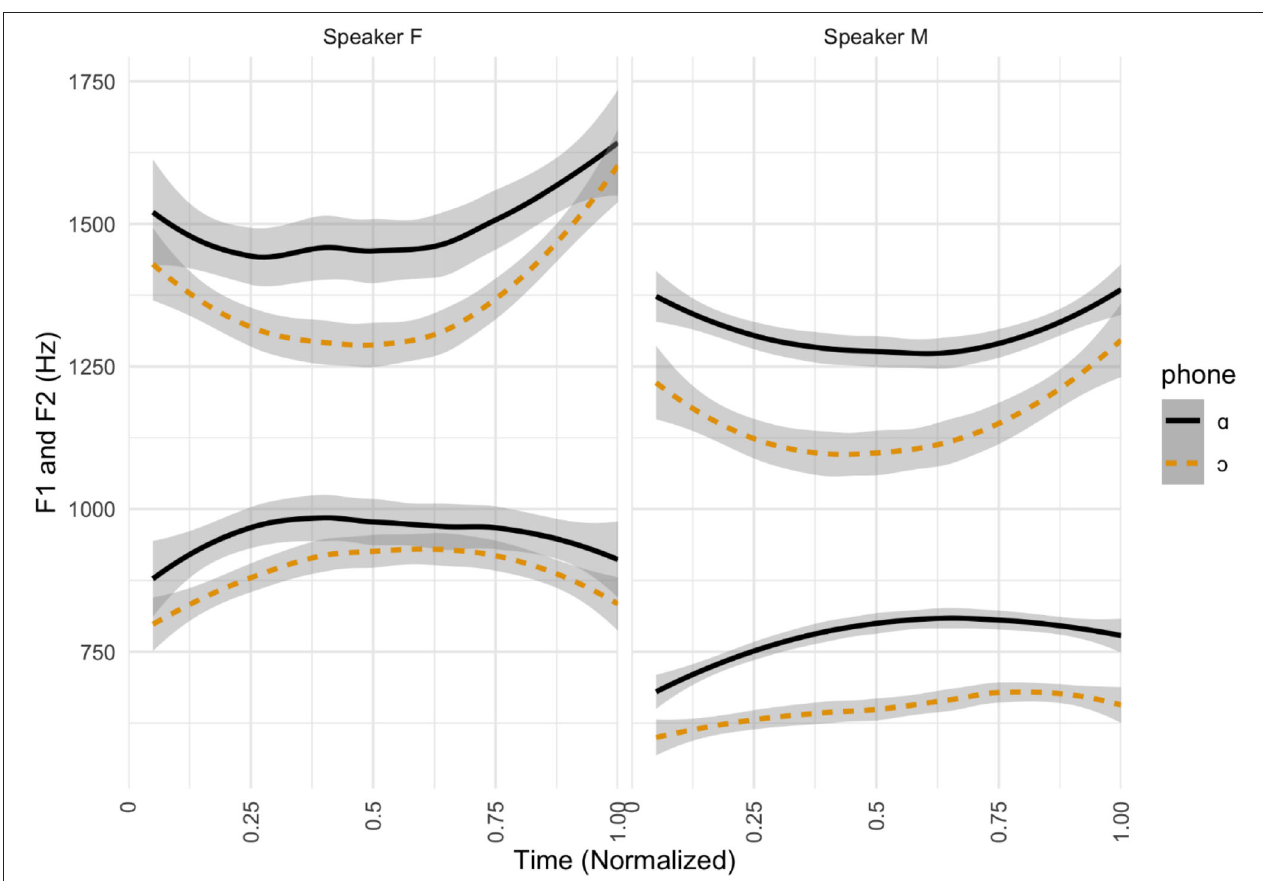
FIGURE 2 | Formant contours for cot-caught stimuli. Time-normalized formant contours (F1 and F2) in Hz for the two speakers providing perception stimuli, separated by target phone. Formants for cot -words are shown in solid black lines and formants for caught -words in dashed orange lines. two words presented on the screen. For example, they